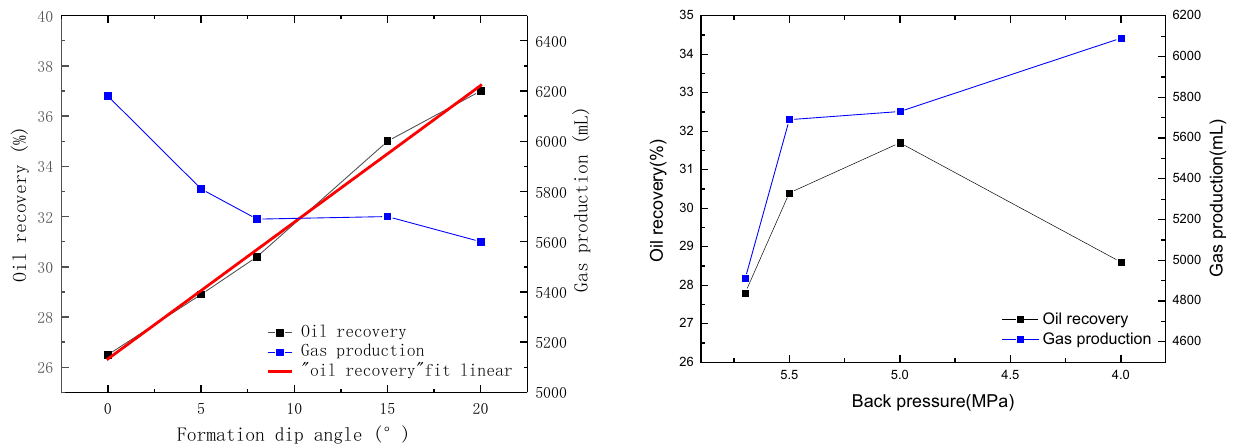
Fig. 5 The influence of formation dip angle on the oil recovery and gas production (experiment condition: temperature 80 °C, gas cap volume 1 PV, pressure of gas cap 1 MPa, back pressure 0.5 MPa)